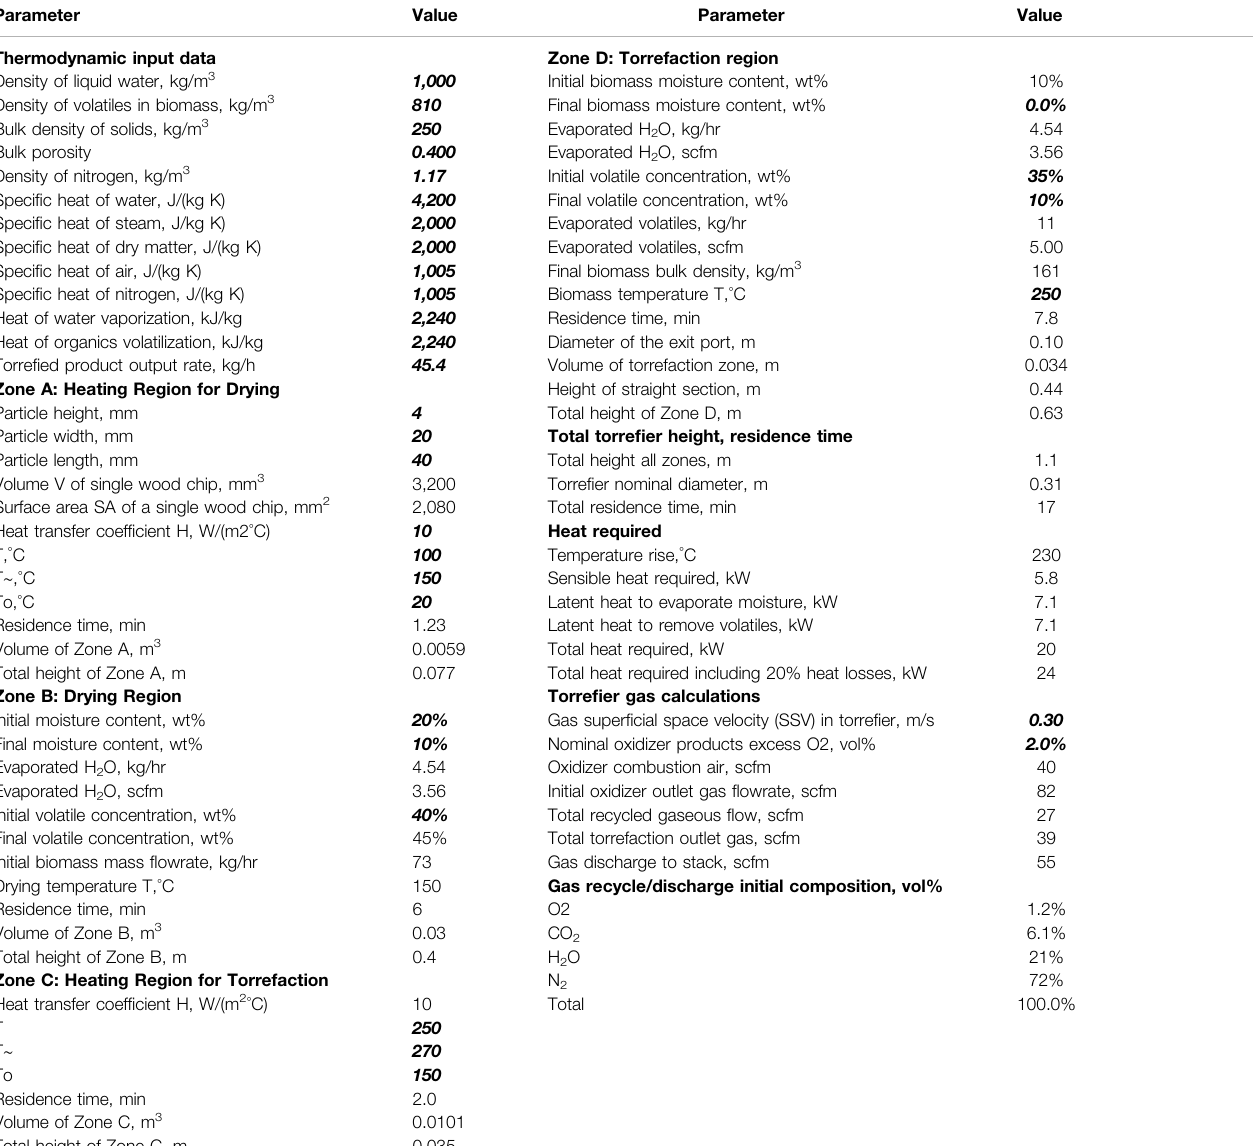
TABLE 4 | Summary torrefaction model input and output